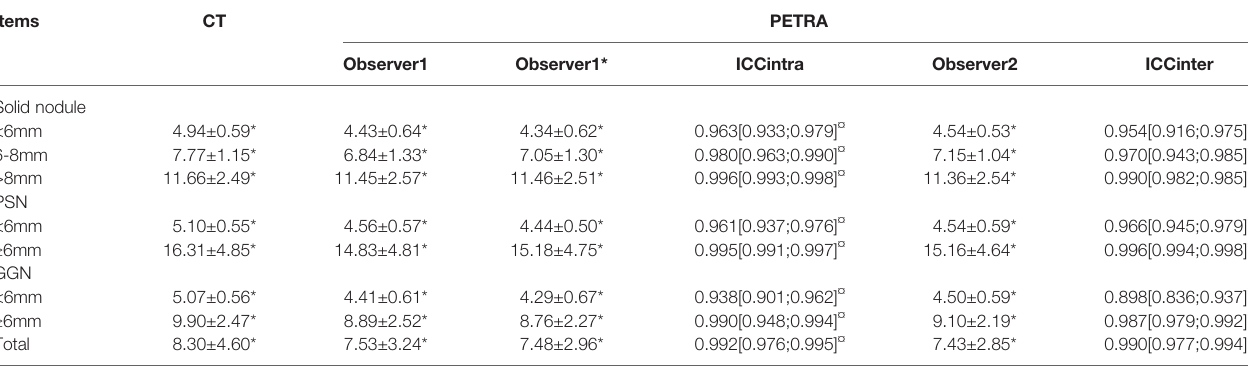
TABLE 4 | Mean diameter of detected nodules for subgroups and agreement of measurements compared to CT.